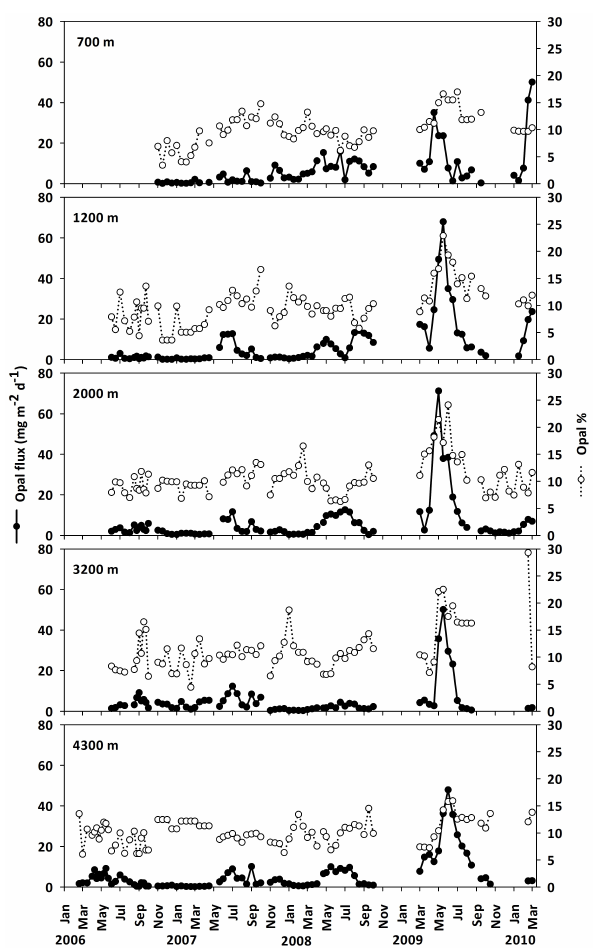
Fig. 9. Time-series plots of lithogenic fraction content (%) and fluxes (mgm − 2 d − 1 ) of downward settling particles collected by sediment traps during the course of the long-term experiment in NESTOR